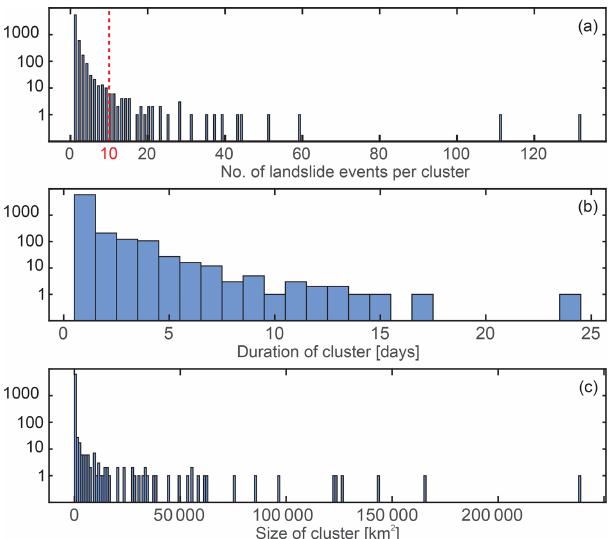
Figure 3. Histogram of the number of events per cluster, duration of clusters, and area of the convex hull of each cluster. Clusters with only a single landslide event were appointed an area of zero. Within this study, all clusters with at least 10 landslide events were analyzed more